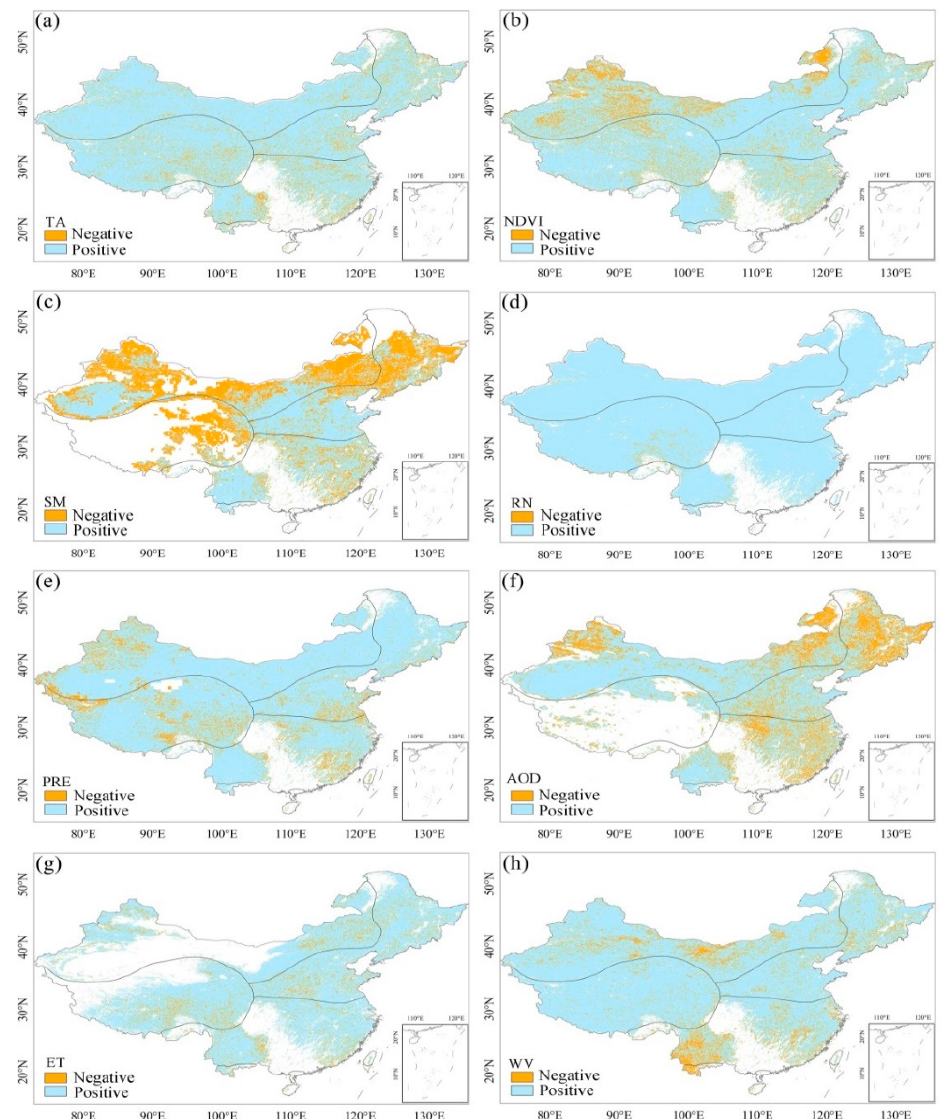
Figure 10. Spatial distribution of multivariate EDM test results. ( a ) TA ( b ) NDVI ( c ) SM ( d ) RN ( e ) PRE ( f ) AOD ( g ) ET ( h ) WV. The blue areas indicate that the forecast skill of the model showed significant improvement ( p < 0.05) with the addition of environmental factors, while the yellow areas indicate that the forecast skills did not show improvement.